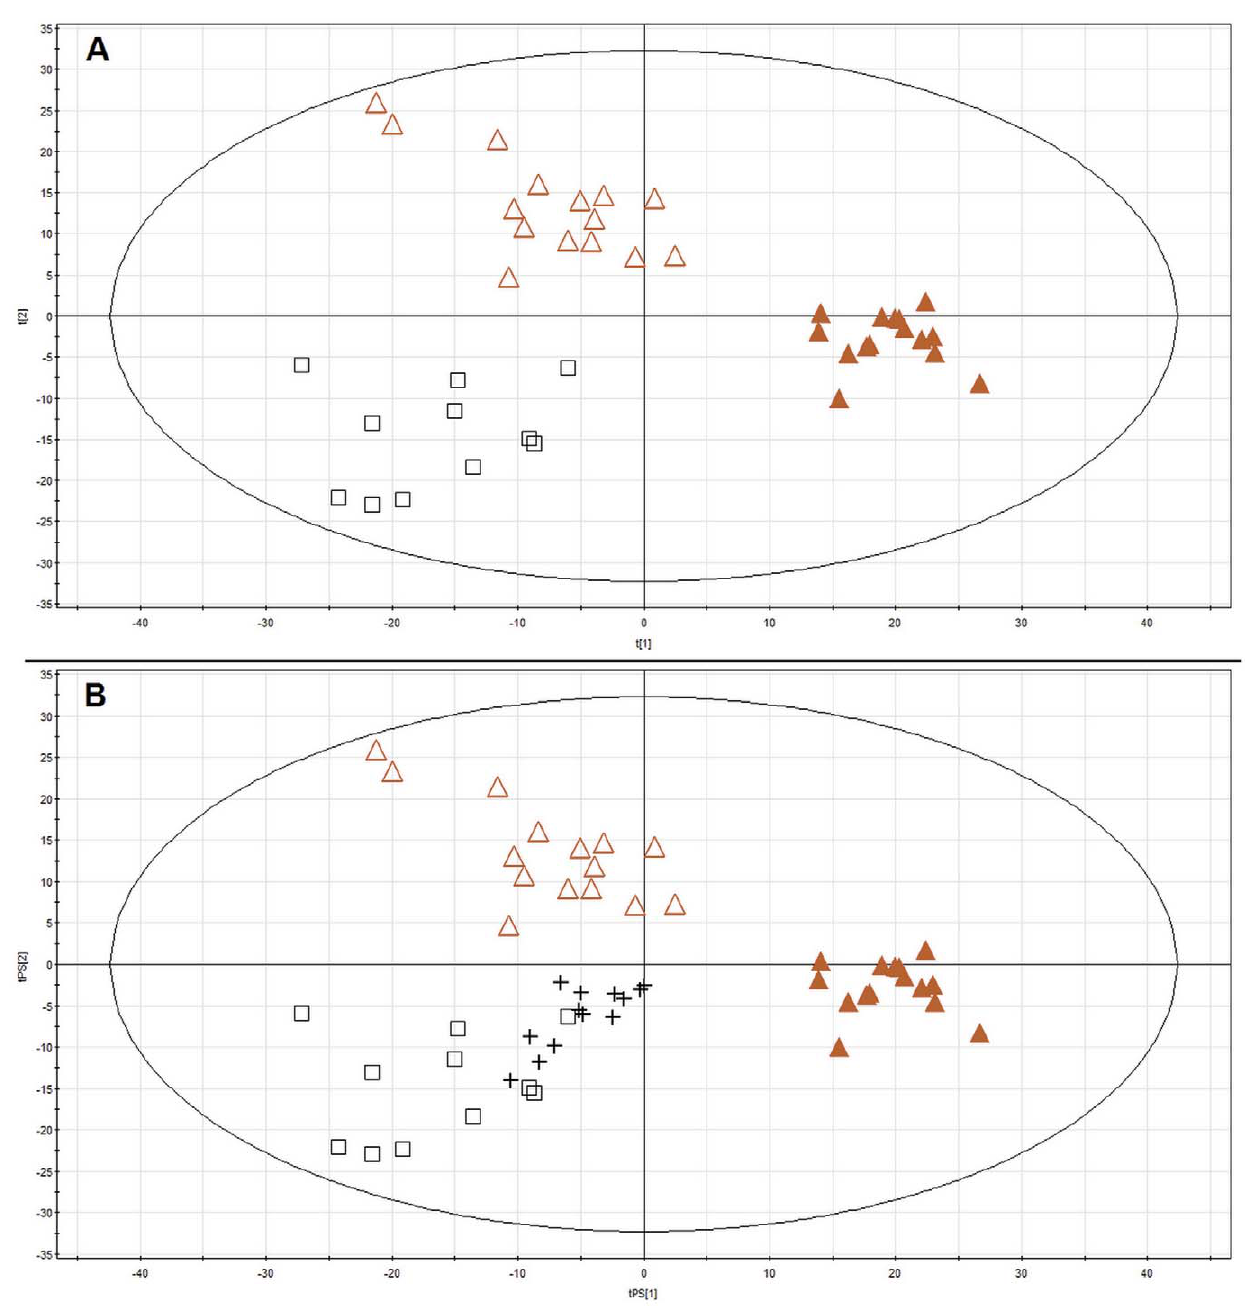
Figure 1. PLS-DA plot of plasma metabolic profiles obtained for patients and controls with prediction for QCs. n - small AAA, m – large AAA, % – control, + - Quality control Panel A shows PLS-DA model (R 2 =0.852, Q 2 =0.369) for all samples and all variables in three groups under investigation (A, S, and C). Panel B shows prediction for QC samples by the model obtained.